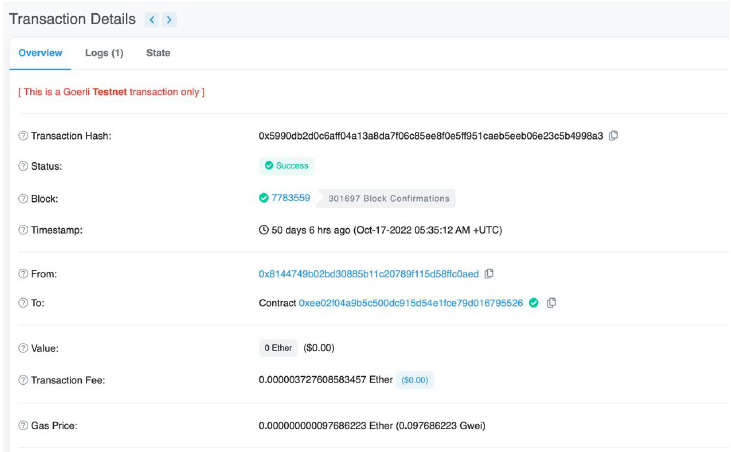
Figure A4. Module for minting currency tokens. Core 1 requests to mint currency token on our website.